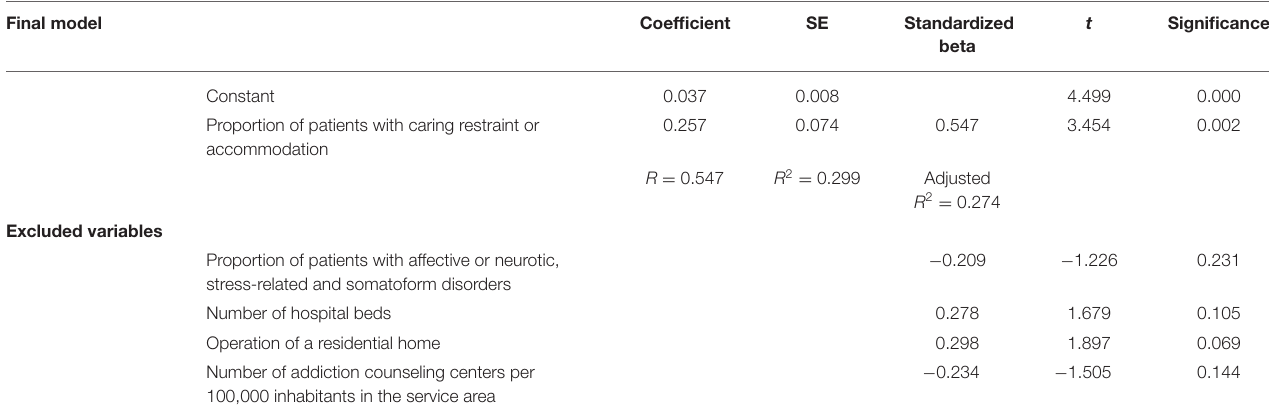
TABLE 4 | Regression